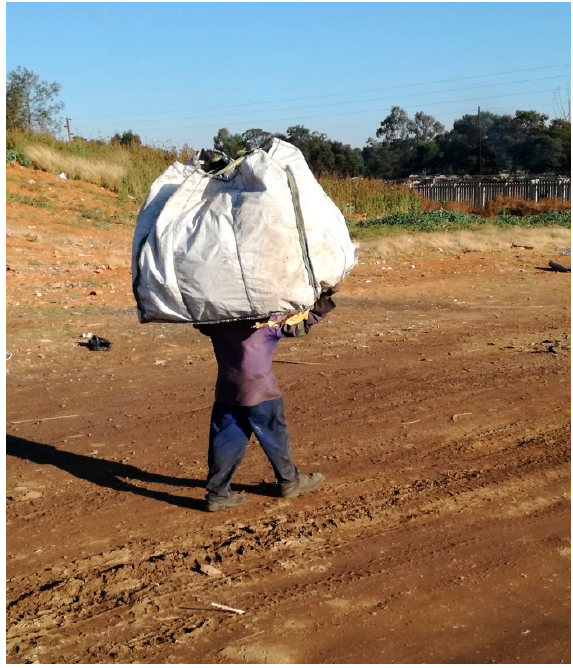
Figure 5. A waste picker carrying a heavy load of waste. Source: Authors.